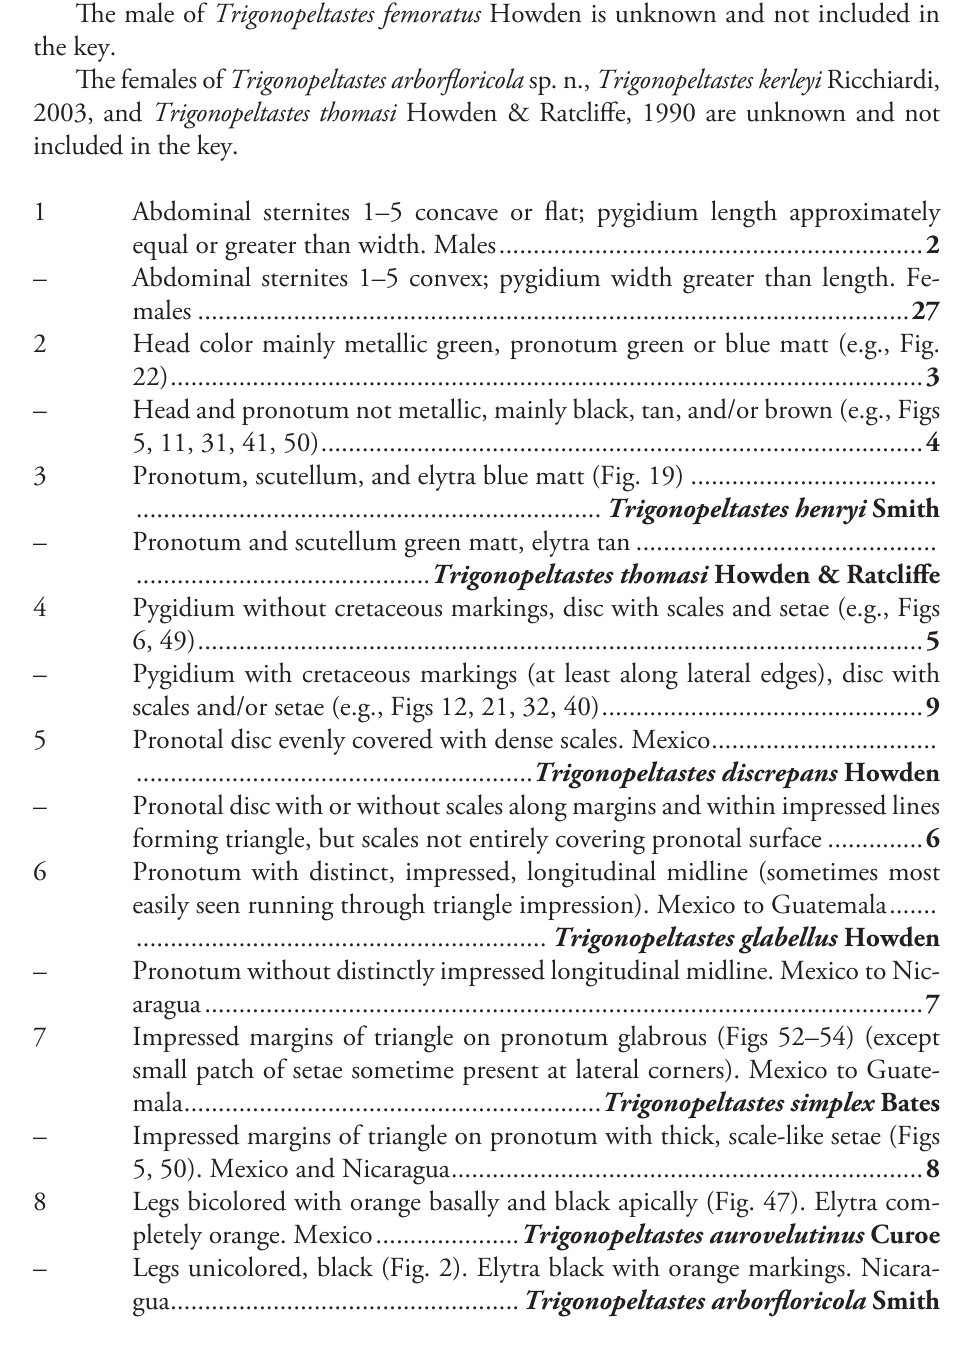
Pronotum with distinct, impressed, longitudinal midline (sometimes most easily seen running through triangle impression). Mexico to Guatemala ....... Pronotum without distinctly impressed longitudinal midline. Mexico to Nic- Impressed margins of triangle on pronotum glabrous (Figs 52–54) (except small patch of setae sometime present at lateral corners). Mexico to Guate- Impressed margins of triangle on pronotum with thick, scale-like setae (Figs Legs bicolored with orange basally and black apically (Fig. 47). Elytra